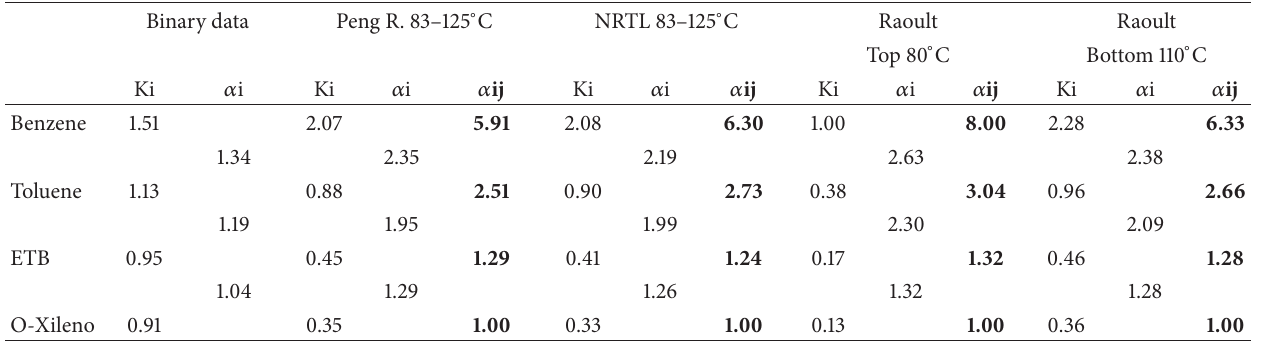
Table 3: Equilibrium constant and relative volatilities for the mixture: benzene, toluene, ethylbenzene, and o-xylene at atmospheric pressure. Binary